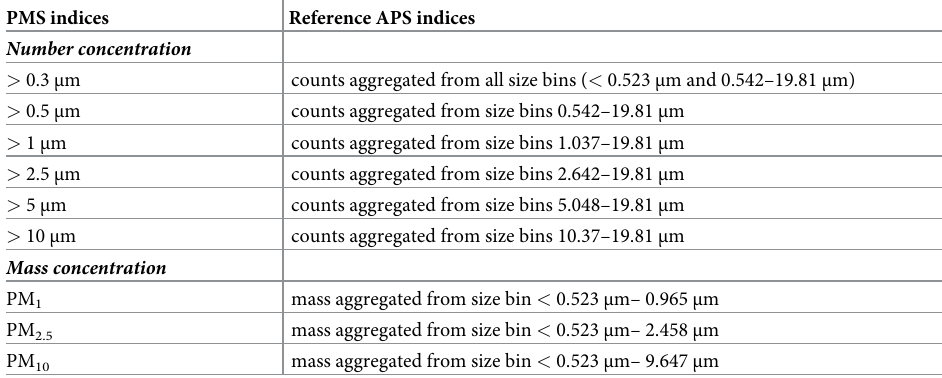
Table 2. The PMS manufacturer’s specified size bins and mass indices with the corresponding reference APS aero- dynamic size bins for